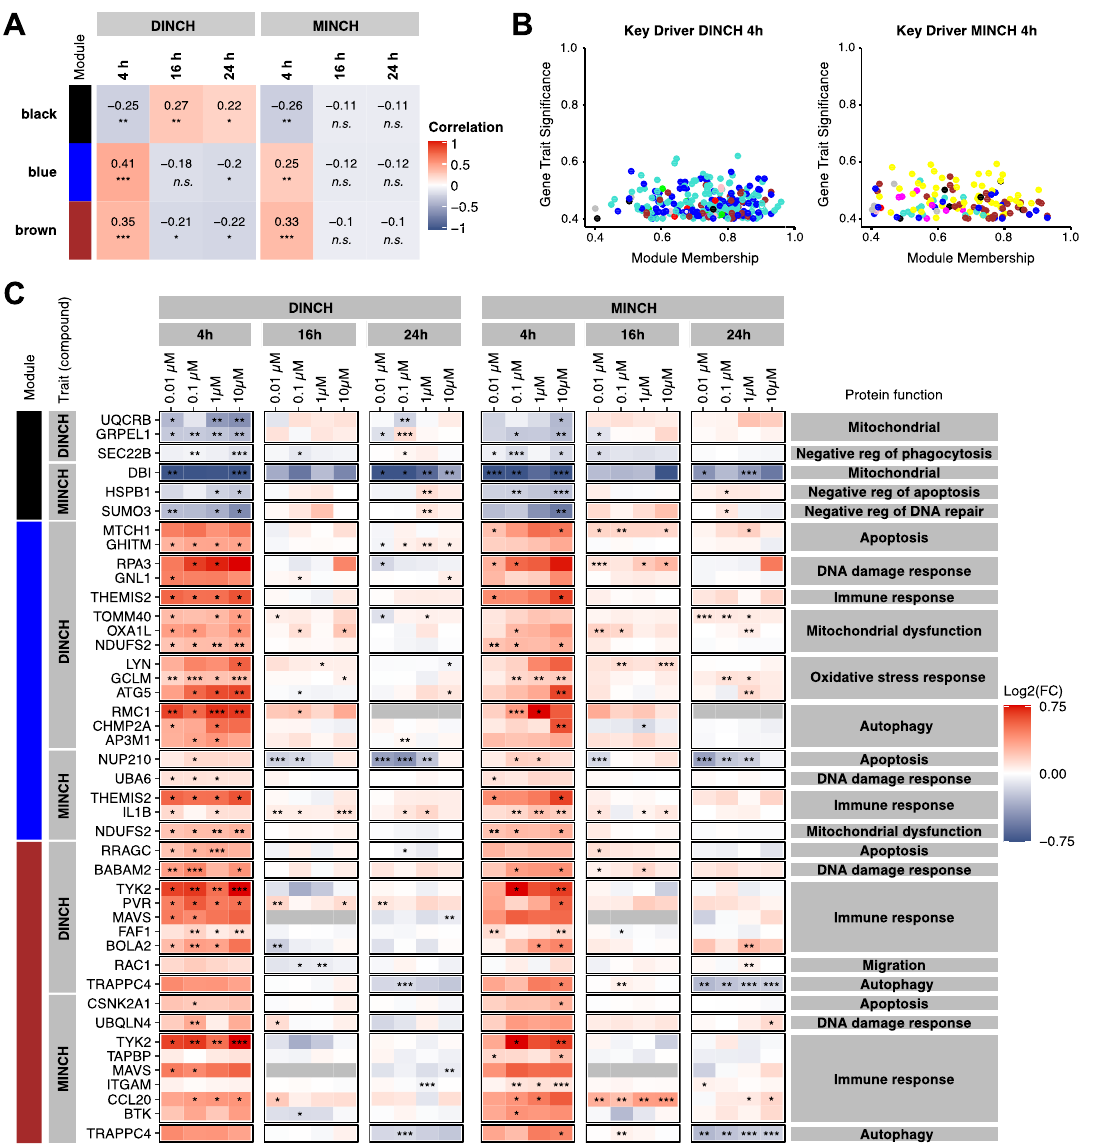
Figure 3. Module-trait correlation and corresponding key drivers obtained by WGCNA. The analysis was based on the Log2(FCs) obtained for the comparison treatment vs. LPS stimulated control (ctrl +LPS). ( A ) Selected modules of co-expressed proteins correlated with compound treatment (DINCH/MINCH) and time point (4 h, 16 h, 24 h). The heatmap is colored according to the correlation, and the significance of the correlation is indicated (n.s. p > 0.05, * p ≤ 0.05, ** p ≤ 0.01, *** p ≤ 0.001). ( B ) Identified key drivers (absolute gene significance ≤ 0.4 and absolute module membership ≤ 0.4) for a 4 h exposure to DINCH or MINCH. Proteins are colored based on their assigned module. ( C ) Selected key drivers for modules black, blue, and brown for the trait 4 h. Log2(FCs) are shown relative to the LPS-stimulated control. Significant changes are labeled with asterisks (* p ≤ 0.05, ** p ≤ 0.01, *** p ≤ 0.001, n = 4).